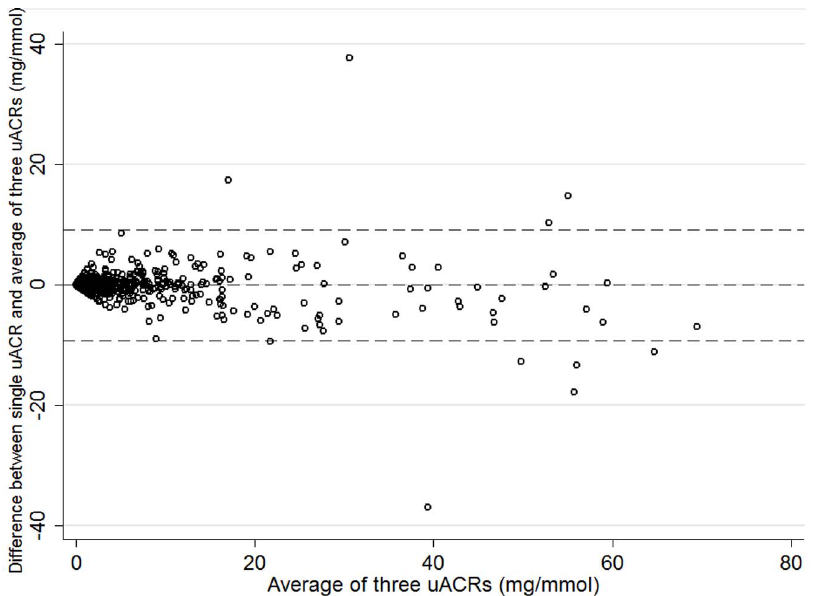
Figure 4. Bland Altman plot showing the distribution of the average of three uACRs against the difference between one uACR and the average of three (figure restricted to people with average uACR , 70 mg/mmol). Explanatory footnote for Figure 4: Horizontal lines represent the mean difference and the 95% limits of agreement in the whole study population (upper=9.20, lower= 2 9.19, mean=0.0064)